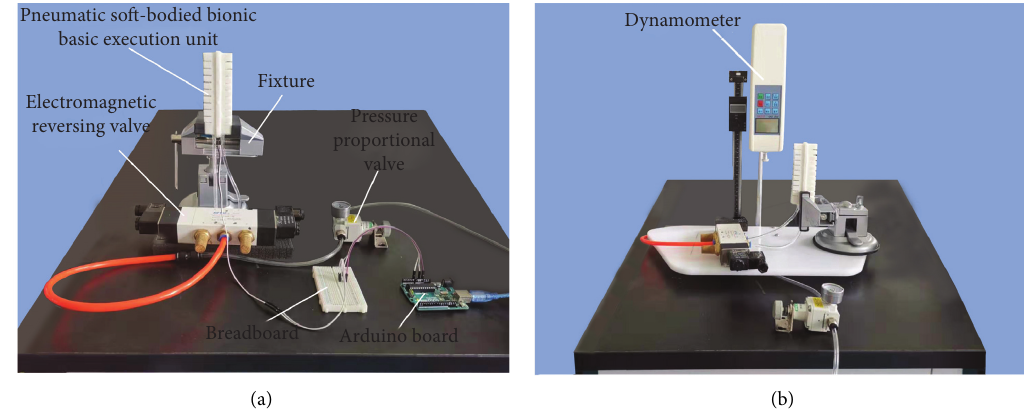
Figure 5: Test platform of pneumatic soft-bodied bionic basic executing unit. Pneumatic soft-bodied bionic basic executing unit is demonstrated with bidirectional structure as an example. (a) Motion characteristics test. (b) Dynamic characteristic